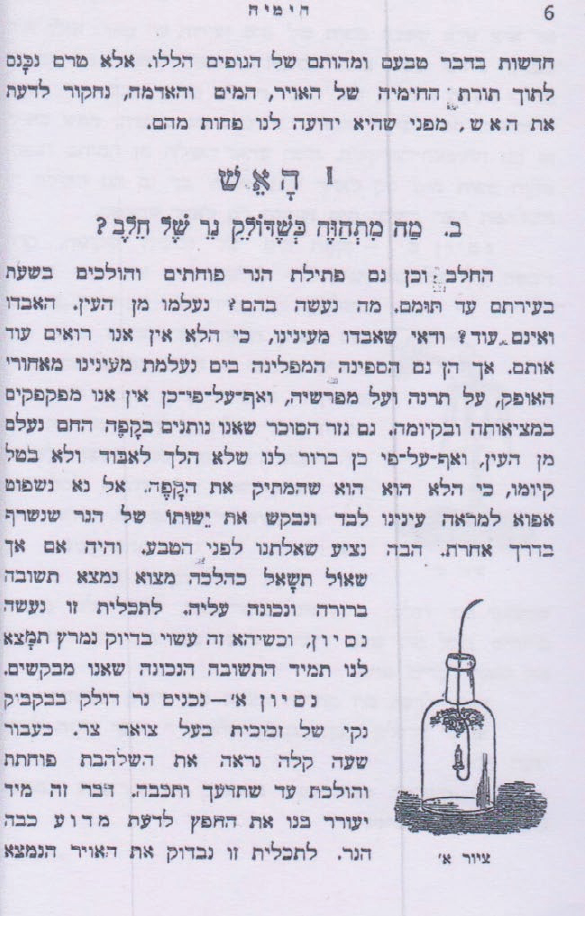
Figure 4. Candle burning experiment in Hebrew,